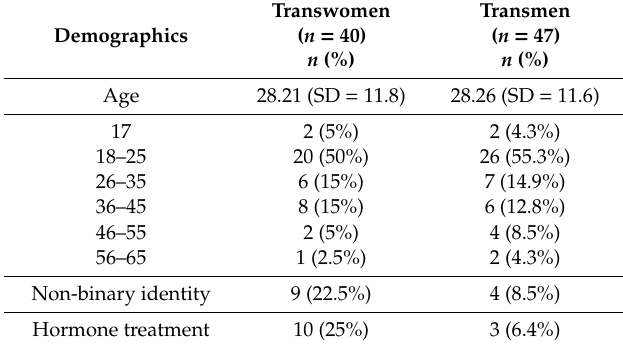
Table 1. Demographic characteristics of the sample ( N =